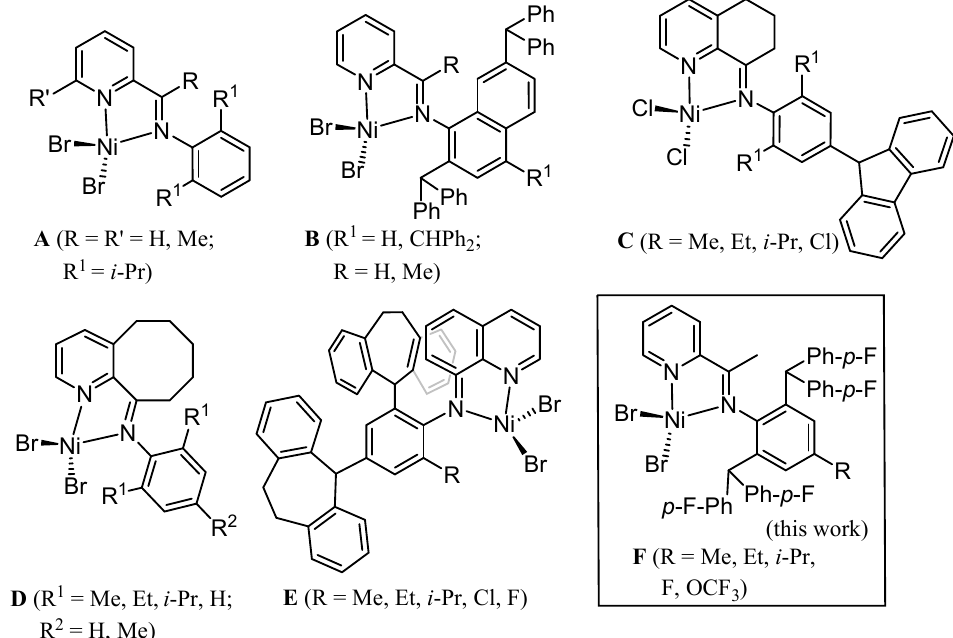
Figure 1. 2-(Arylimino)pyridine-nickel(II) halide ( A ), its substituted derivatives, ( B – E ), and the target of this work, ( F ).